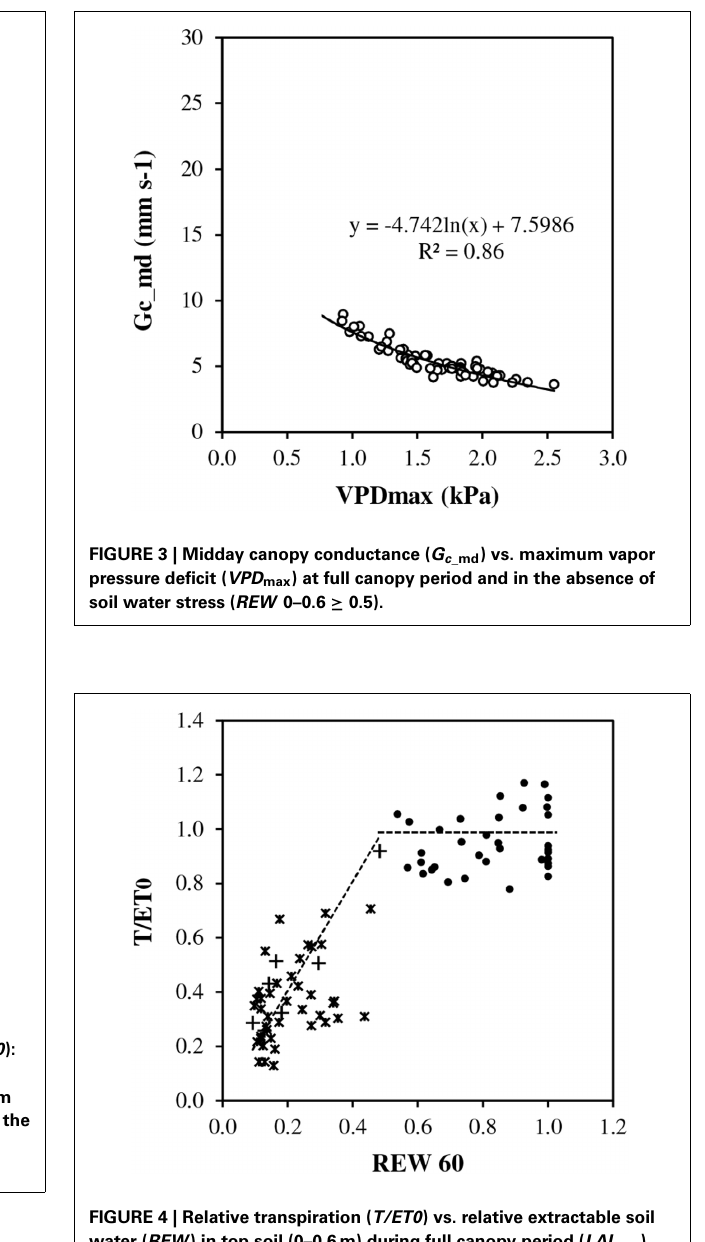
FIGURE 4 | Relative transpiration ( T/ET0 ) vs. relative extractable soil water ( REW ) in top soil (0–0.6m) during full canopy period ( LAI max ), closed circles indicate REW ≥ 0 . 5 and ET 0 < 2 . 3mm d − 1 , asterisks indicate REW < 0.5 and ET 0 ≥ 2 . 3mm d − 1 and plus signs indicate REW < 0 . 5 and ET 0 < 2 . 3mm d − 1 . Trends are shown as dotted lines, averaged as 1.0 for REW ≥ 00 . 5 and as a reduction coefficient for REW < 0 .